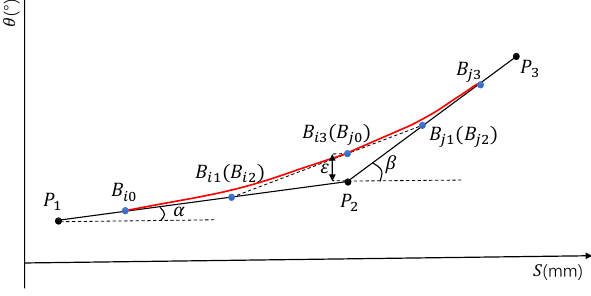
Figure 10. Control points for smooth curve.